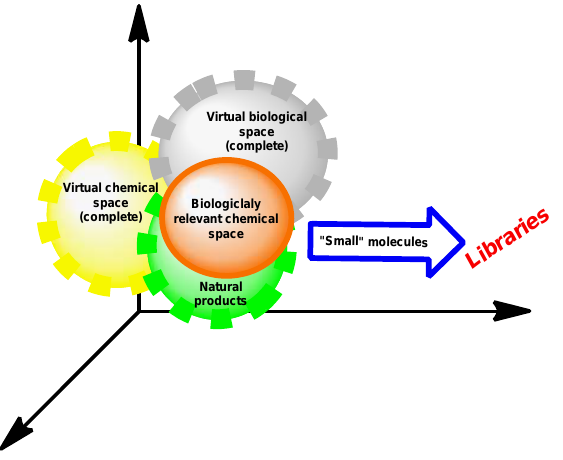
Figure 3. Chemical and biological space